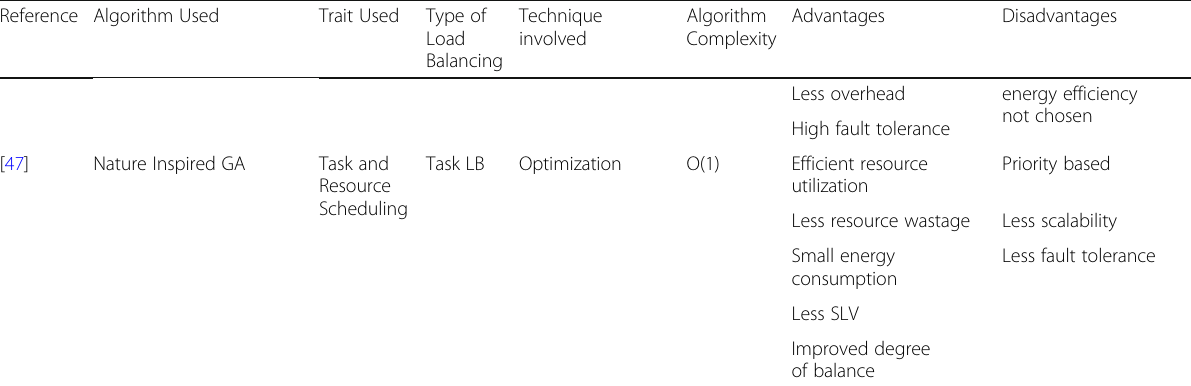
Table 1 Proactive approaches of Cloud load balancing in existing literature (Continued) Reference Algorithm